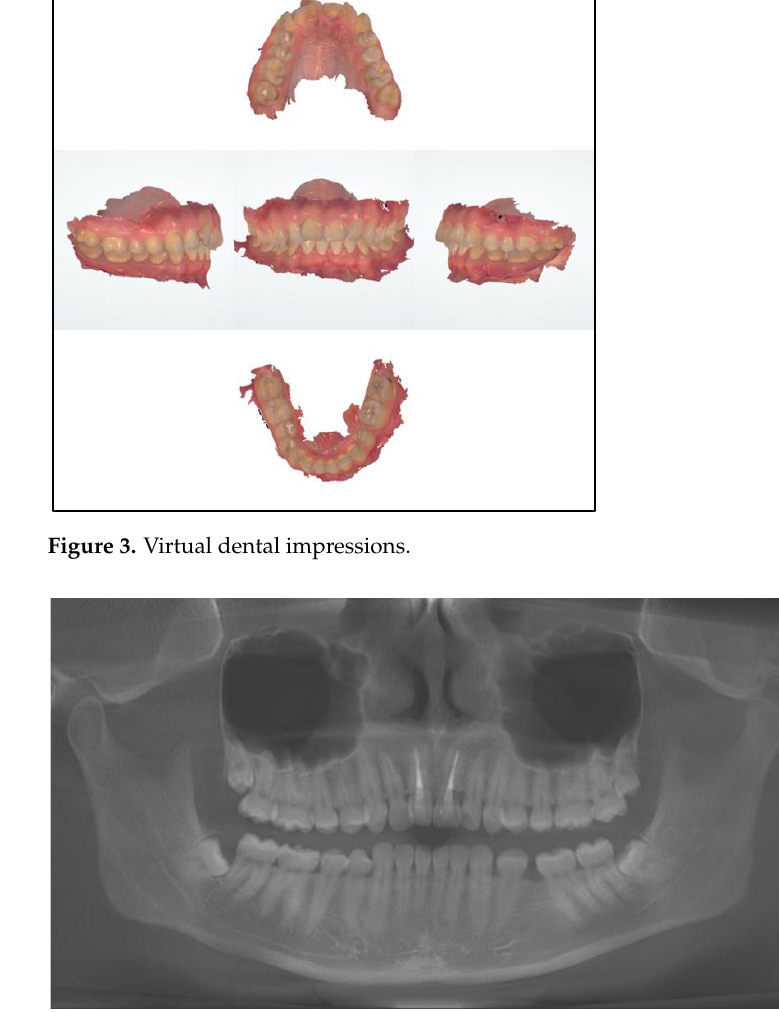
Figure 4. Initial panoramic radiograph.